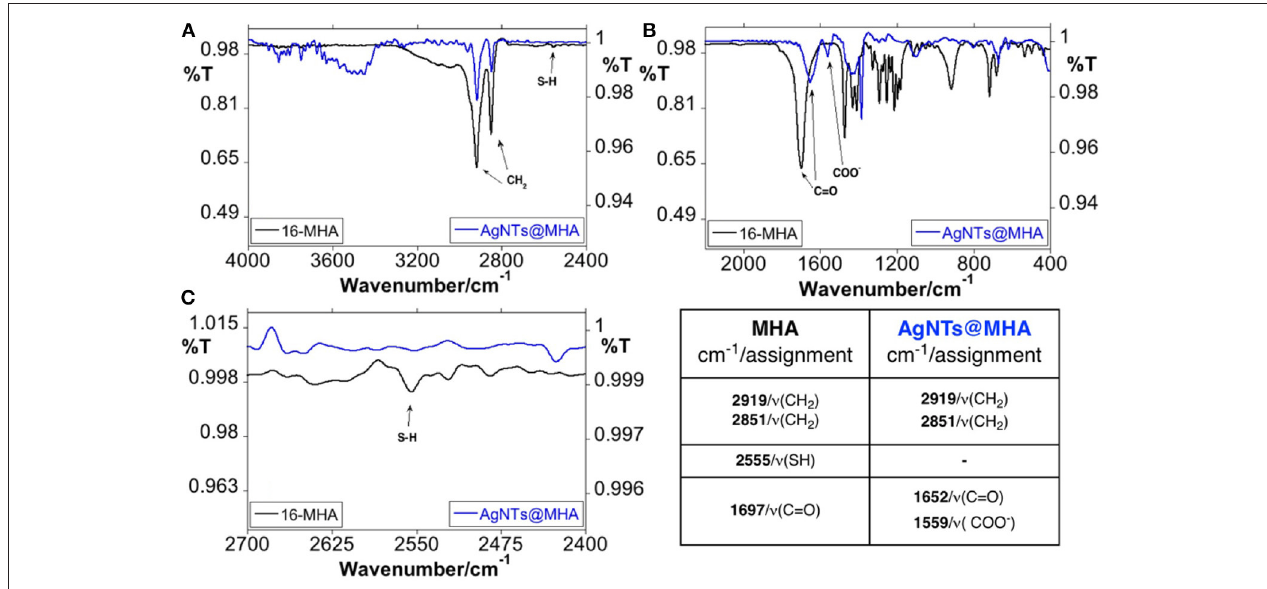
FIGURE 3 | FT-IR spectroscopic profile of 16-MHA and AgNTs@MHA in KBr disk. Overview between 4,000 and 2,400 cm − 1 (A) and 2,000–400 cm − 1 (B) . Enlargement spectra in the S-H region between 2,700 and 2,400 cm − 1 (C) and peak table.